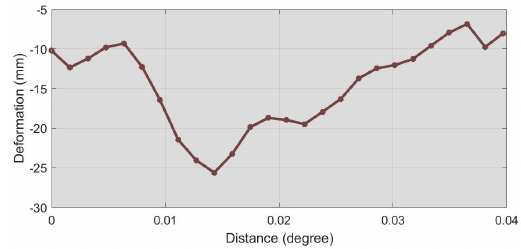
Figure 4. The profile of deformation